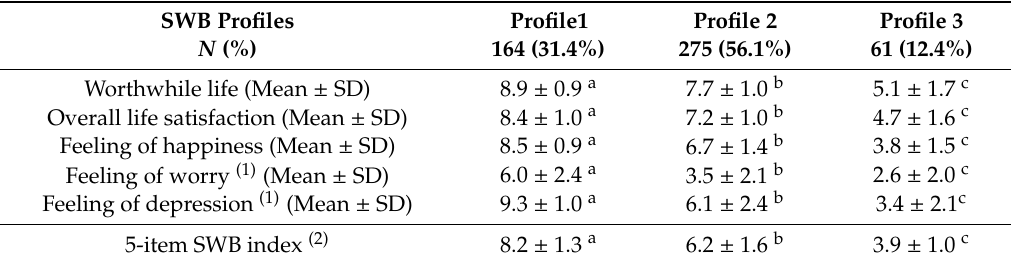
Table 5. Profiles of subjective well-being (SWB) in the studied population.